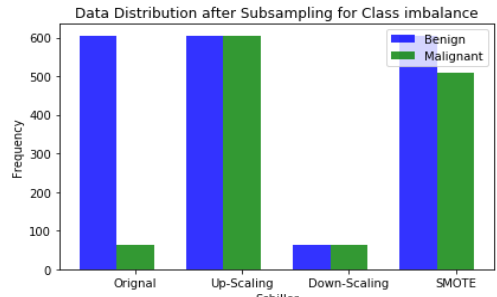
Figure 3 . Balanced dataset for target variable Schiller